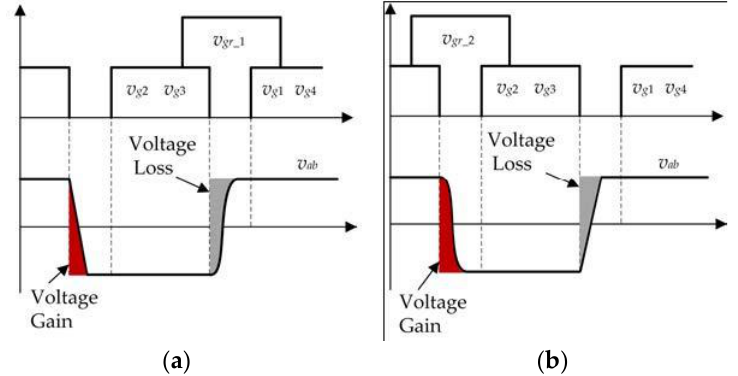
Figure 5. The pole voltage and voltage error in a switching cycle: ( a ) i o > 0 and ( b ) i o < 0.